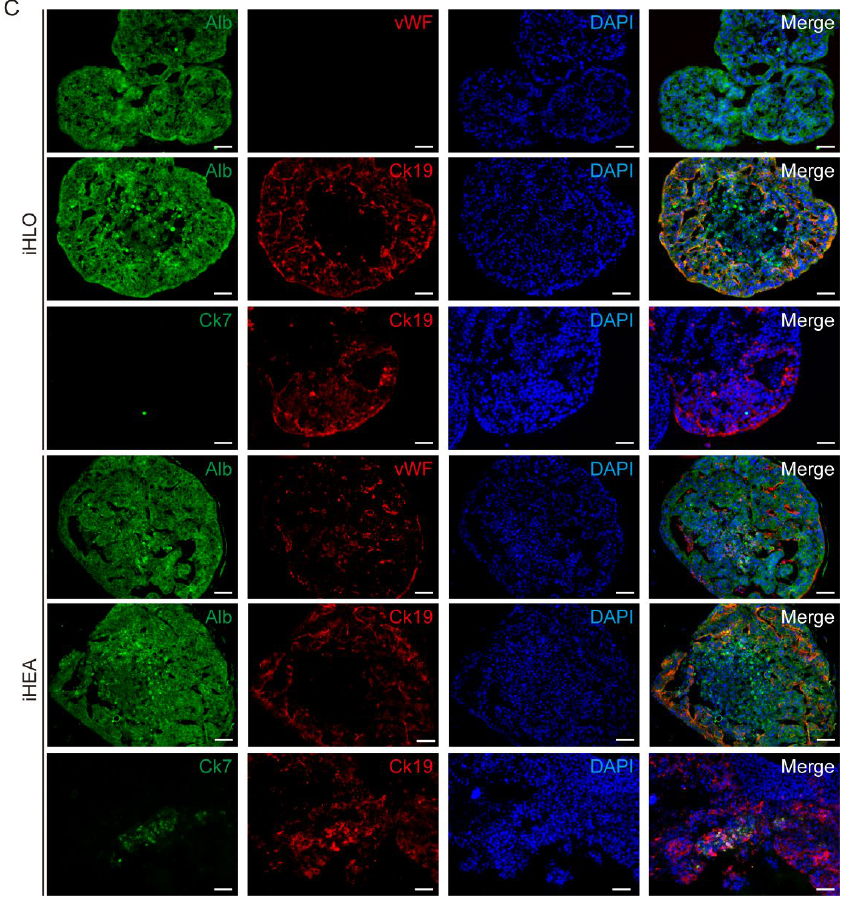
Figure 1. Generation of liver assembloid using induced hepatic stem cells (iHepSCs) and induced endothelial cells (iECs). ( A ) Schematic illustration of generating liver assembloids by encapsulating iHepSCs and iECs in Matrigel and type I collagen hydrogel. iHepSCs were obtained by direct conversion of fibroblasts using transcription factors, Oct4 and Hnf4 α , and iECs were obtained by direct conversion of fibroblasts using transcription factor ETV2 (liver organoid generated with iHepSC spheroid encapsulated in hydrogel = iHLO; liver assembloid generated with iHepSC spheroid encapsulated in hydrogel that contains iEC = iHEA). ( B ) Microscopic images of the morphology of iHLOs and iHEAs from days 1 to 14 (scale bar: 250 µ m). ( C ) Immunofluorescence images of iHLOs or iHEAs stained with hepatic lineage markers (Alb and Ck19), endothelial cell lineage markers (vWF), and cholangiocyte lineage markers (Ck19 and Ck7). The cells were counterstained with DAPI. Scale bar: 50 µ